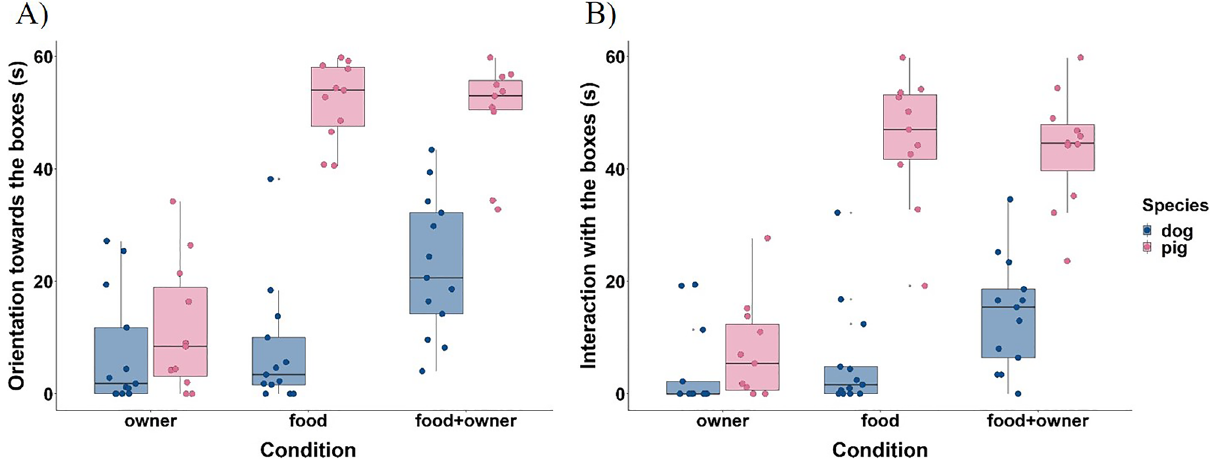
Figure 2. Time spent orienting towards the boxes ( A ) and interacting with them ( B ) for both species. Boxplots indicate the median, 25th and 75th percentiles (boxes), and the minimum and maximum (whiskers). Dots represent individual data